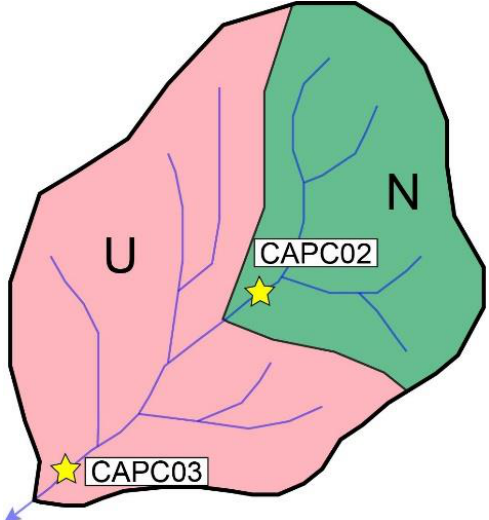
Figure 4. Conceptual model of a controlled experiment to determine if the CADR is influenced by urban construction in the Phoenix area. N refers to natural land cover and U refers to urban land cover. The sediment sample collected from the upper-subcatchment (CAPC02) represents the CADR of a nature preserve setting, while the sediment sample collected from the lower-subcatchment (CAPC03) represents the CADR impacted by a highly disturbed catchment that was experiencing ongoing suburbanization through the creation of a subdivision.